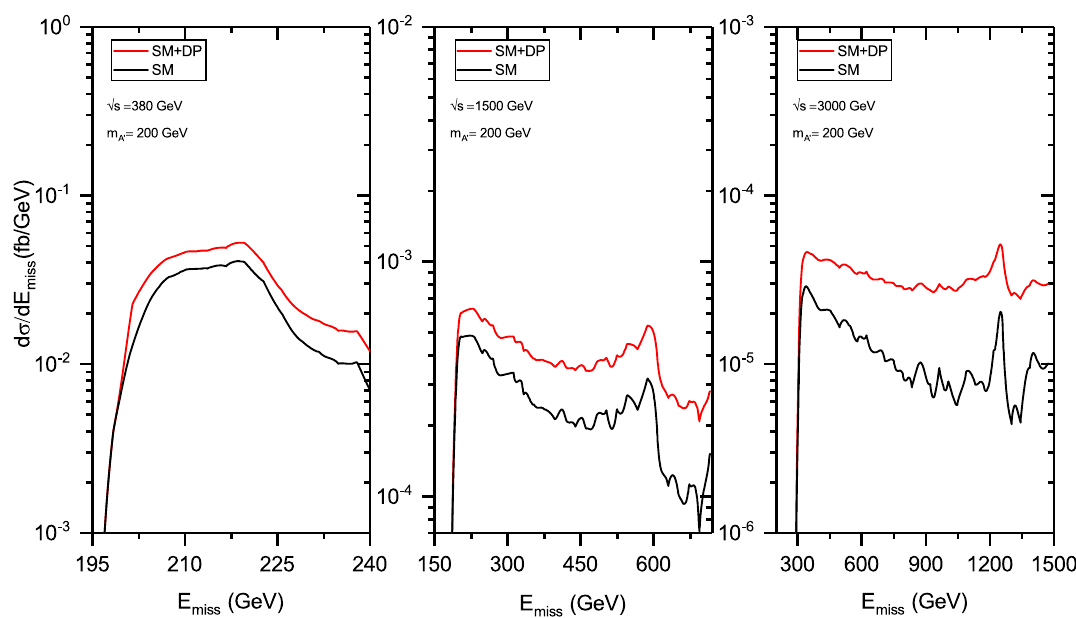
contributions. It turns out that DP is the dominant effect for high missing energy values. We have also made calculations for different values of m A (cid:2) . Our calculations show that devi- ations of the cross sections from the SM predictions become smaller as the DP mass m A (cid:2) grows. The excluded bounds for the massive DP going to invisible final states are presented in Figs. 9 and 10 in the plane the